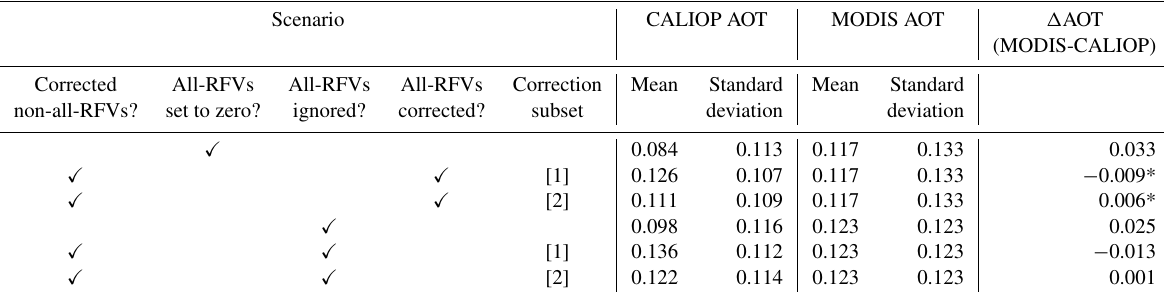
Table 3. For February 2008 over cloud-free global oceans: the mean and standard deviation of collocated CALIOP and MODIS AOTs for various scenarios related to the treatment of non-all-RFV and all-RFV CALIOP aerosol profiles. For those scenarios that involve correction, [1] refers to analyses including all cloud-free CALIOP profiles over global oceans, while [2] refers to analyses restricted to CALIOP points collocated with MODIS AOTs between 0.03 and 0.07. The corresponding aerosol extinction profiles used for RFV correction are shown in Fig. 9. Key results are highlighted with an asterisk.